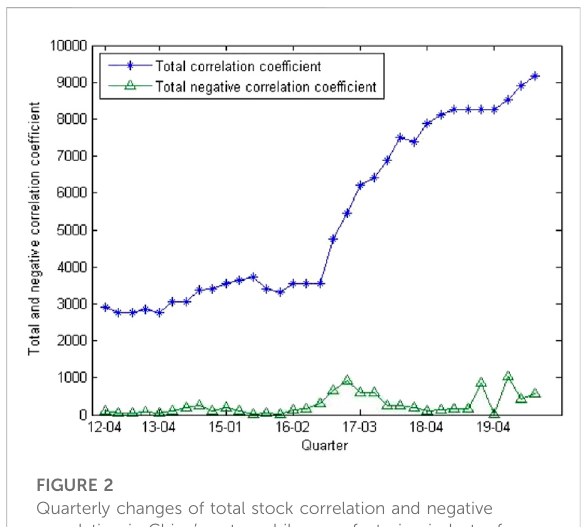
FIGURE 2 Quarterly changes of total stock correlation and negative correlation in China ’ s automobile manufacturing industry from 2012 to